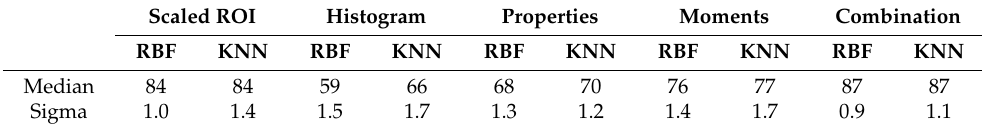
Table 9. Best F1 score results of the tested feature extraction